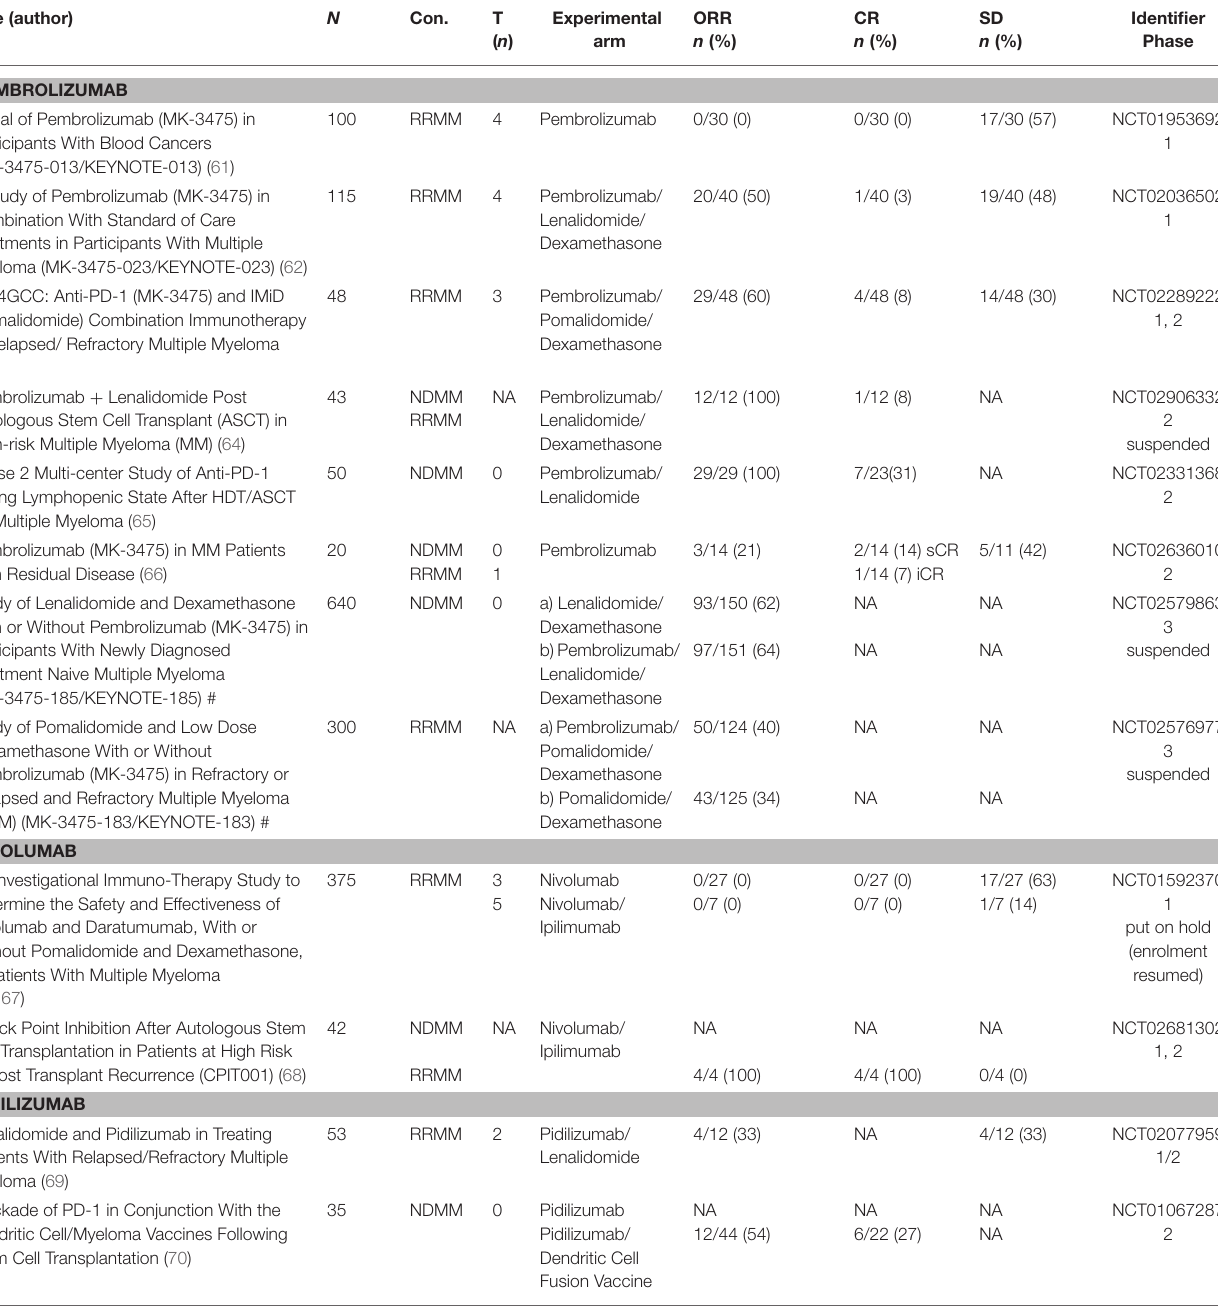
TABLE 1 | Available results of clinical trials with PD-1/PD-L1 inhibitors in multiple